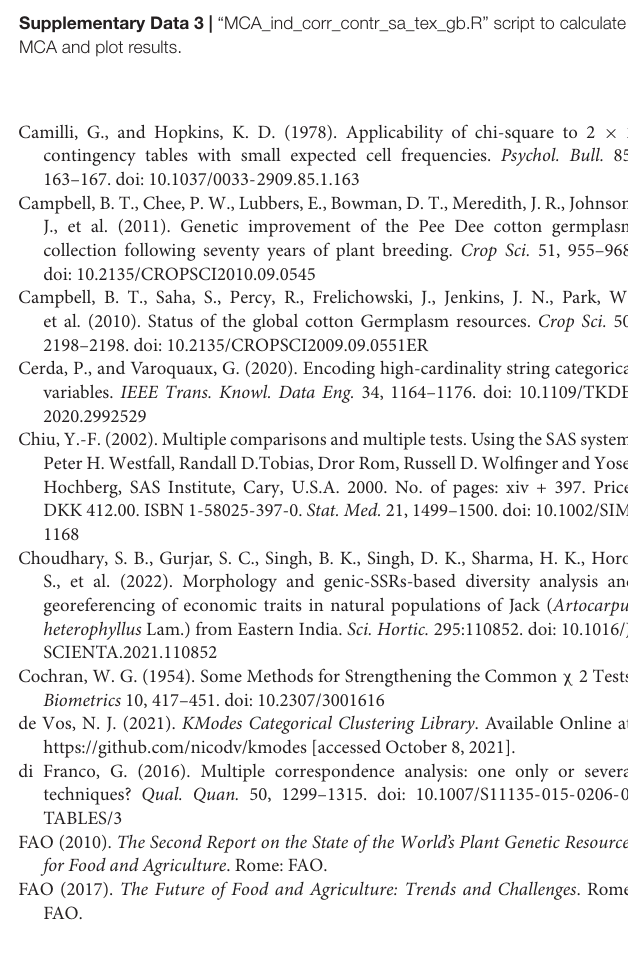
Supplementary Table 1 | Standardized descriptors and rating reported by USDA-ARS College Station. Supplementary Table 2 | SA_mod.xlsx – input dataset for bivariate analysis. Supplementary Table 3 | TEX_mod.xlsx – input dataset for bivariate analysis. Supplementary Table 4 | gb_mod_PAG.xlsx – input dataset for bivariate analysis. Supplementary Table 5 | Categorical descriptors encoded for bivariate and clustering analysis. Supplementary Table 6 | Modified states in categorical analysis for statistical purposes. Supplementary Table 7 | Integrated dataset of SA, TEX, and Gb accessions for unsupervised clustering. Supplementary Table 8 | Two cluster results and IDs identified. Supplementary Table 9 | Three cluster results and IDs identified. Supplementary Table 11 | Values and corresponding charts are provided for SA, TEX, and Gb. Supplementary Data 1 | Updating and expanding definitions and rating